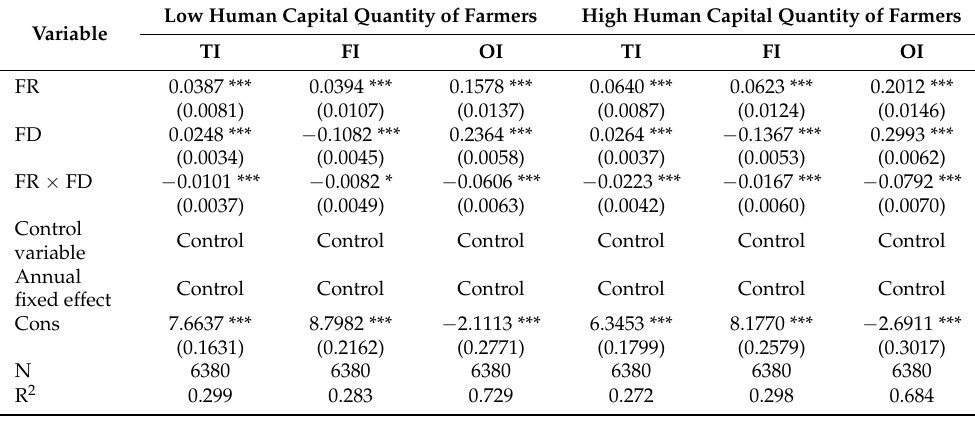
Table A6. Impact of collective forestland tenure reform on households’ income under different human capital